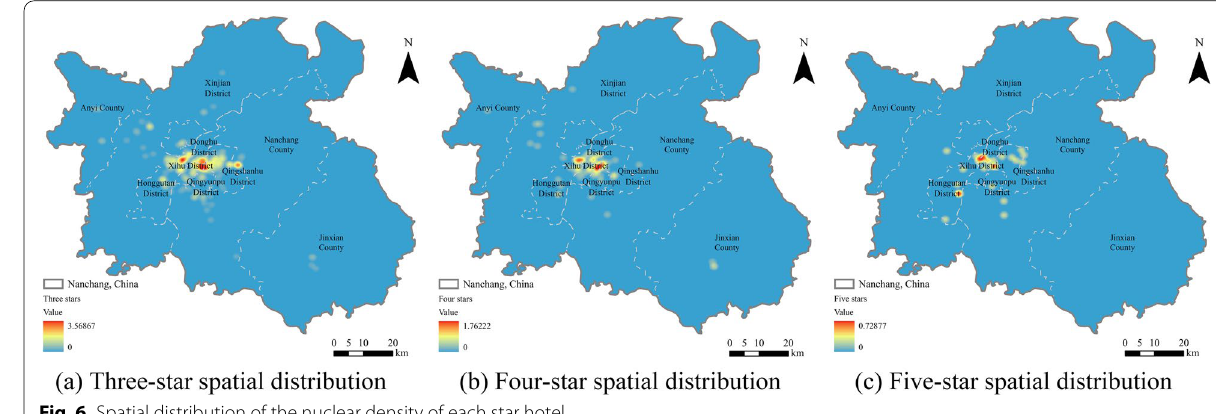
Fig. 6 Spatial distribution of the nuclear density of each star hotel